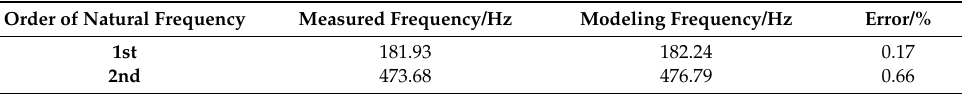
Figure 16. Frequency response. Table 7. The pipe: comparison of the measured and modeling frequencies.